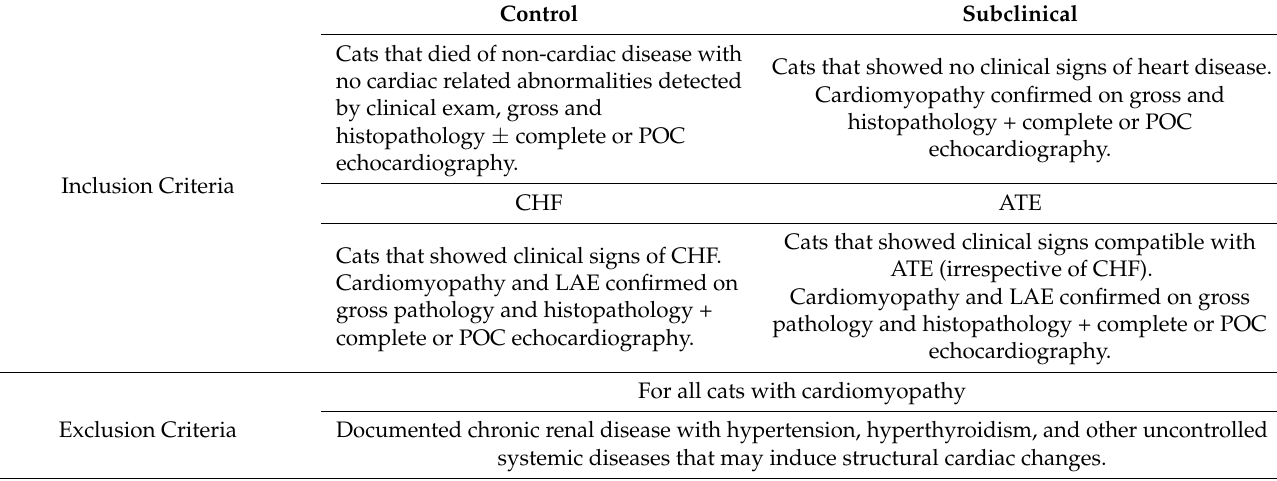
Table 1. Inclusion and exclusion criteria for case selection of cats by pathological